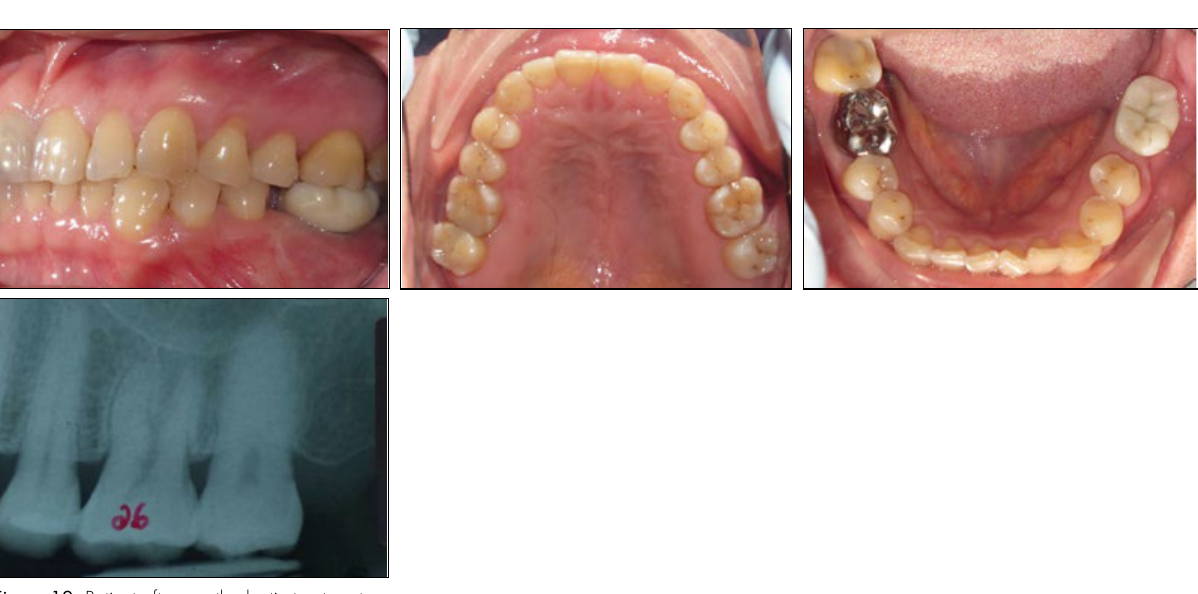
Figure 10. Modified lever arm for an additional slight intrusion of the first upper molar.